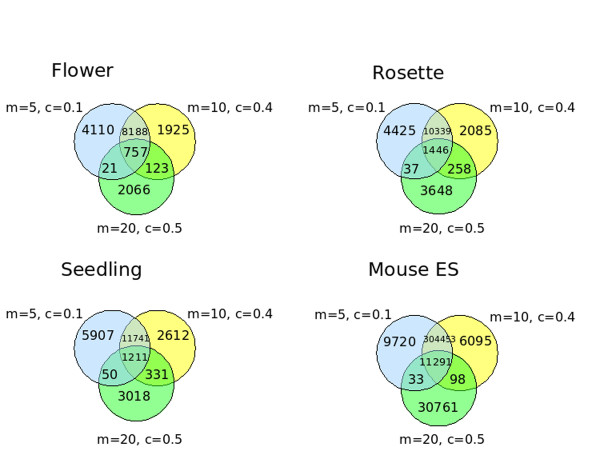
Venn diagrams of numbers of exactly the same locales appearing in Arabidopsis and mouse tissues at 3 sets of paramater values within the sensitive range. The number of locales with exactly the same start and stop coordinates on the same chromosomes appearing uniquely in each parameter set or in all combinations of sets were calculated.